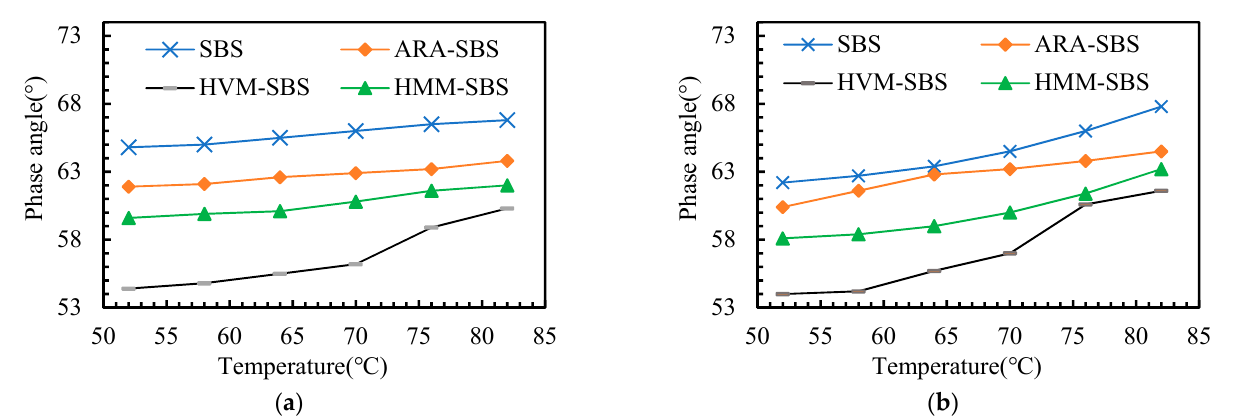
Figure 5. Phase angle of the asphalt binders after aging: ( a ) TFOT; ( b ) PAV.